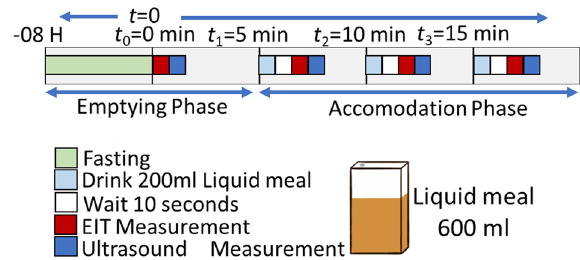
Figure 5. Experimental protocol.